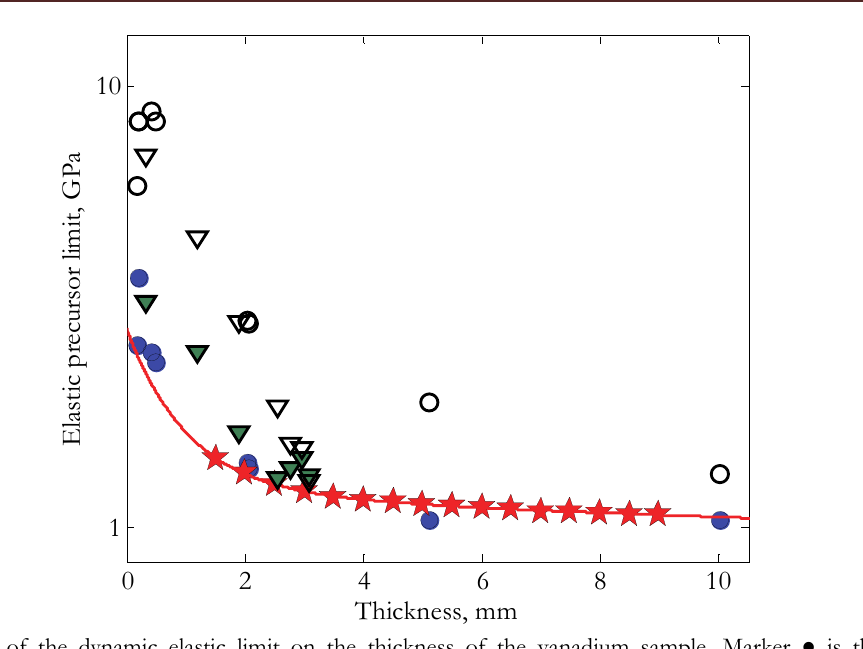
Figure 6: Dependence of the dynamic elastic limit on the thickness of the vanadium sample. Marker ● is the minimum value (experiment) [25], ○ − maximum value (experiment) [25], ▼ − minimum value (experiment [24]), ∇ − maximum value (experiment [ 25]), − numerical calculation, solid line – approximation.